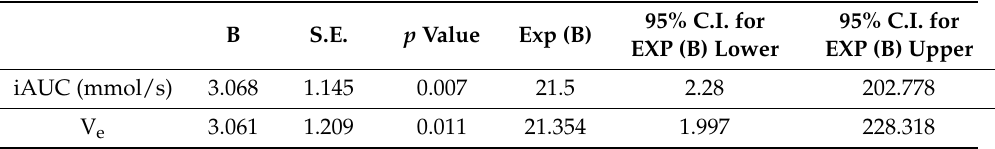
Table 4. Logistic regression for disclosing the probability occurrence of PDAC.